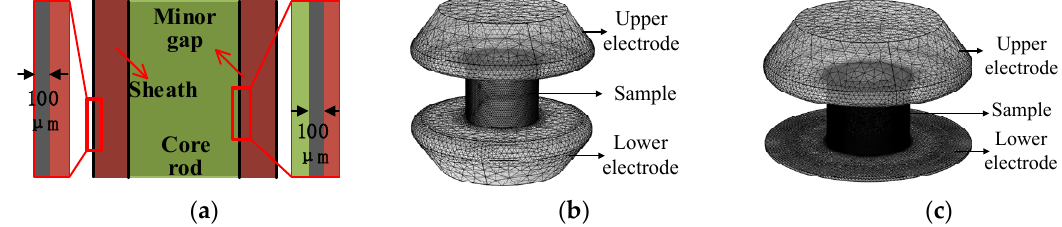
Figure 5. Simulation models: ( a ) Sample profile; ( b ) Conventional electrode; ( c ) Improved electrode.